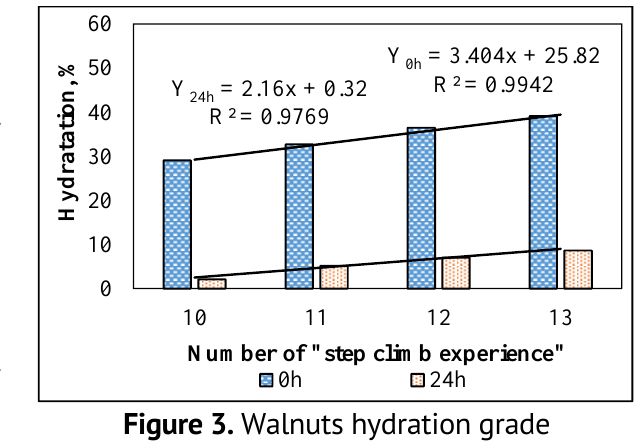
Figure 3. Walnuts hydration grade after extraction.